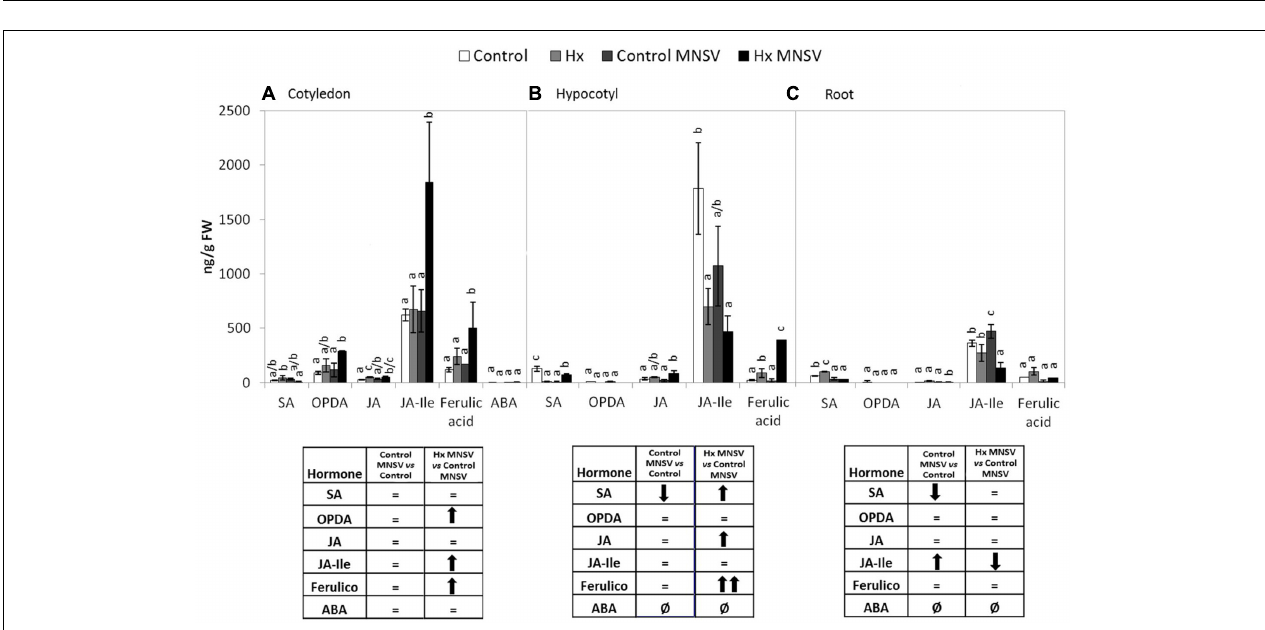
FIGURE 4 | Effect of Hx treatment on oxidative burst after MNSV infection. Plants were grown and inoculated as described in Figure 3C . Melon cotyledons were sampled at 24 hpi, 5, 12, and 18 dpi, and H 2 O 2 accumulation was visualized by DAB staining. (A) Quantification was performed by determining the number of brown pixels on digital photographs. Data show average values of the standard errors ( n = 10) of the relative number of brown or yellow pixels per photograph. Letters indicate significant differences between treatments at each time point ( p < 0.05; least-significant difference test. (B) Representative photographs were taken of H 2 O 2 accumulation in the mock and Hx-treated plants upon MNSV infection.